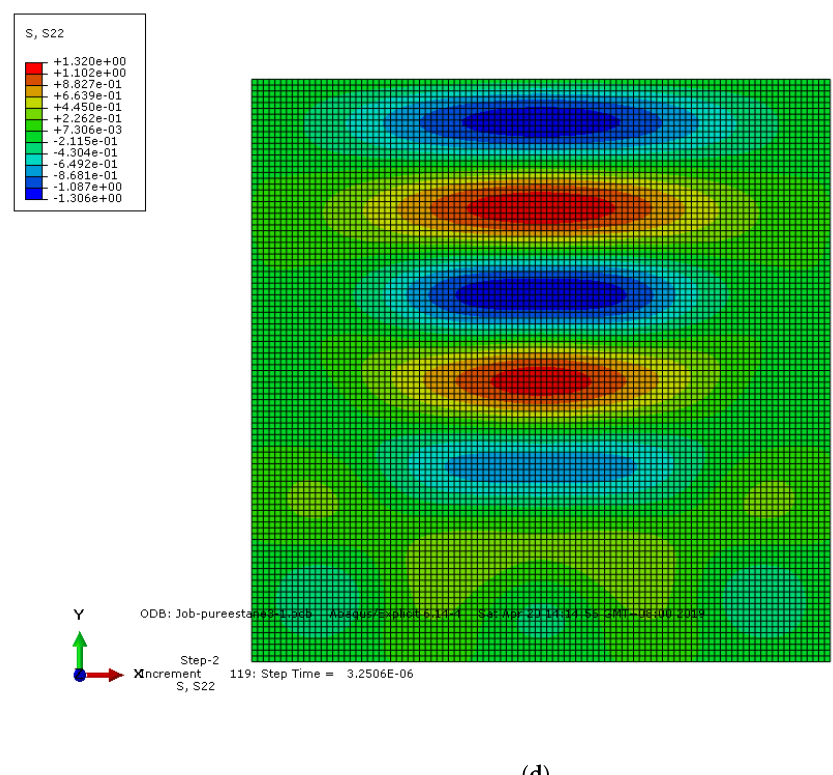
Figure 9. Cloud propagation of a 1 MHz ultrasonic wave in the binder (Estane) after ( a ) 1, ( b ) 2, ( c ) 4, and ( d ) 8.25 µ s. In addition, a finite element simulation of the ultrasonic attenuation of the pure binder was established and compared with the later two-phase RDX/Estane material to determine the main factors affecting the ultrasonic attenuation coefficient. From the finite element analysis, we obtained the attenuation coefficients at different frequencies using Equation (12). The attenuation coefficient is roughly proportional to the ultrasonic fre- quency, as shown in Figure 10. Identically, R 2 represents the correlation coefficient be- tween the approximating functions and measurement points.